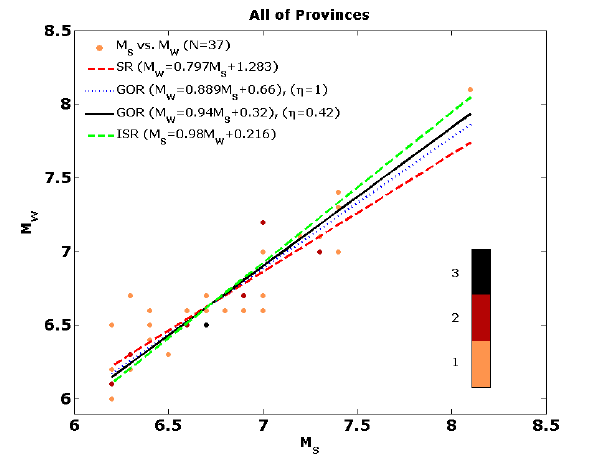
Figure 5. M –M conversion relations for the Iranian Plateau S w (M >6.1). Abbreviations as Figure s mated conversion relation M method for the merged data sets.